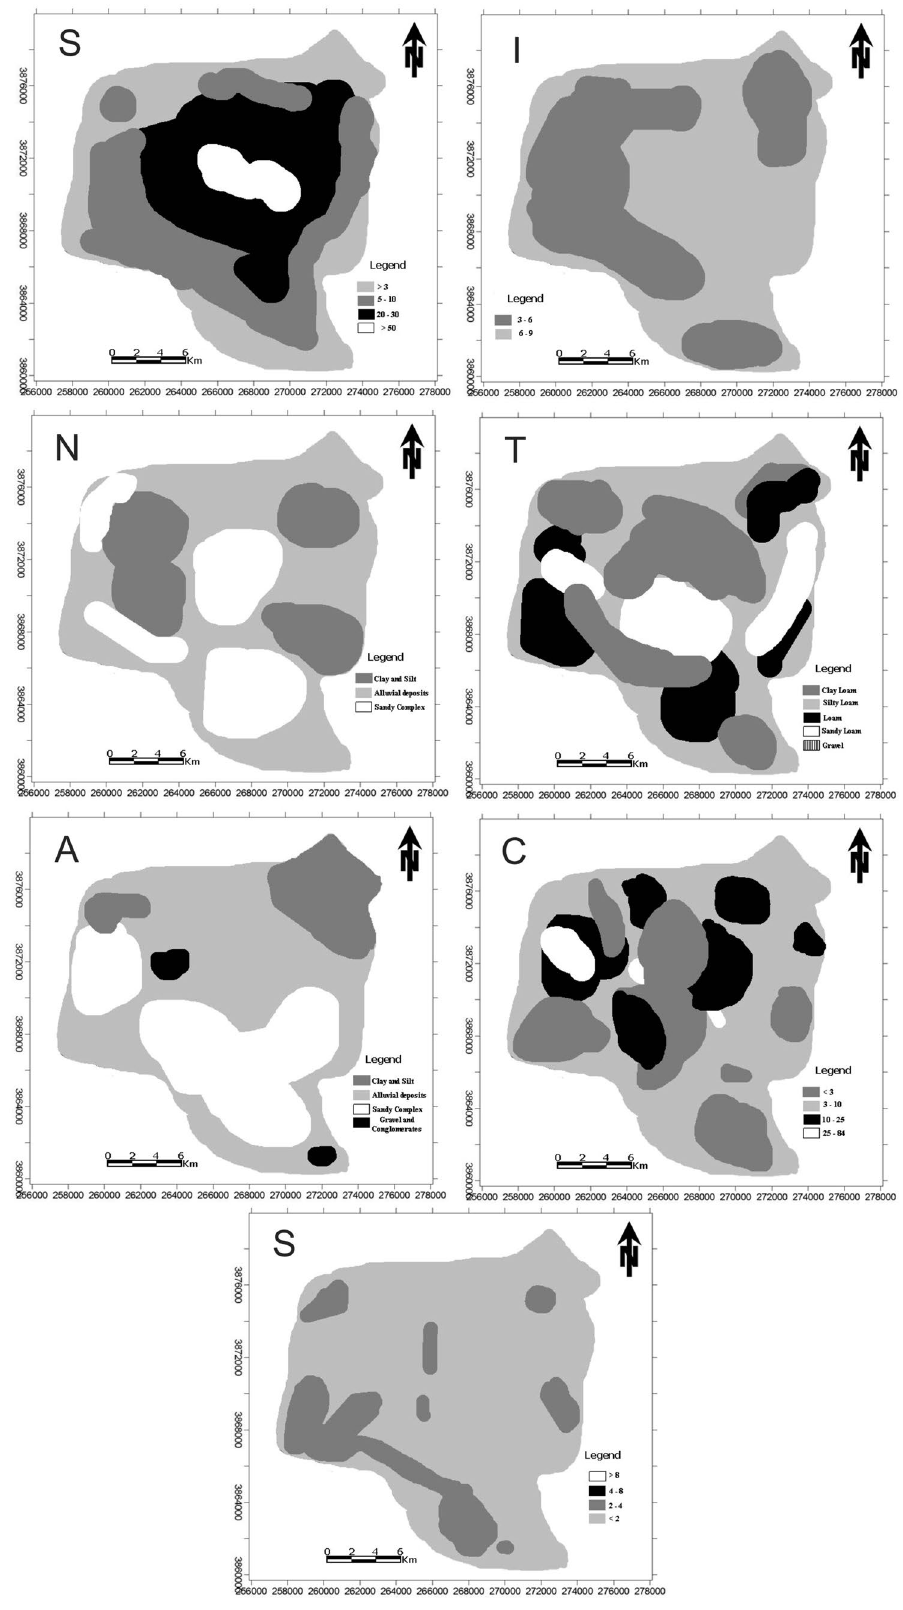
Fig. 5 Mapping of SINTACS model